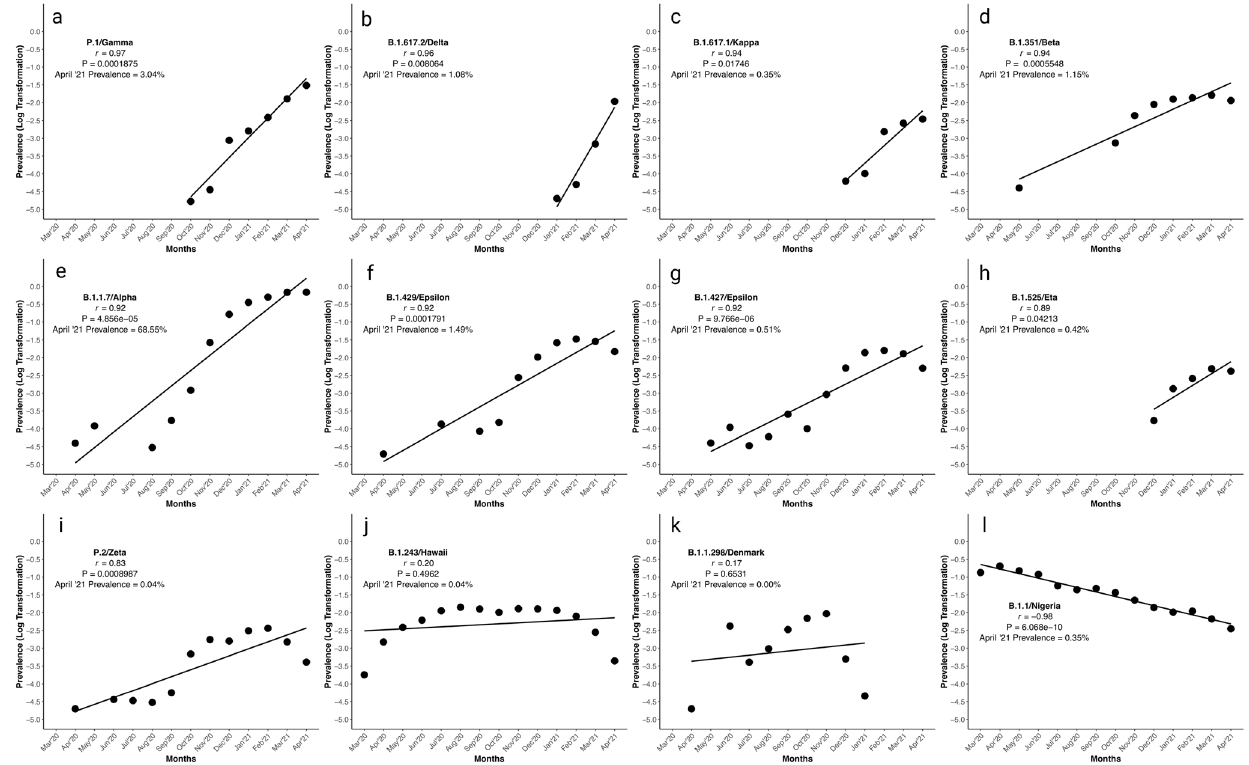
Fig. 2 Pearson ’ s correlation on logarithmically-transformed prevalence ratios of SARS-CoV-2 variant of concern, variants of interest, and other lineages. This fi gure demonstrates the quantitation of SARS-CoV-2 variants of concern, variants of interest, and other lineages. The emergence and disappearance of variants/lineages of SARS-CoV-2 is evaluated by Pearson ’ s correlation of logarithmic transformation prevalence data ( n = 1,479,378 biologically independent samples). Variants are displayed in order of decreasing r value. Pearson ’ s correlation of logarithmic transformed prevalence versus time as a interval value for SARS-CoV-2 lineages a P.1, b B.1.617.2, c B.1.617.1, d B.1.351, e B.1.1.7, f B.1.429, g B.1.427, h B.1.525, i P.2, j B.1.243, k